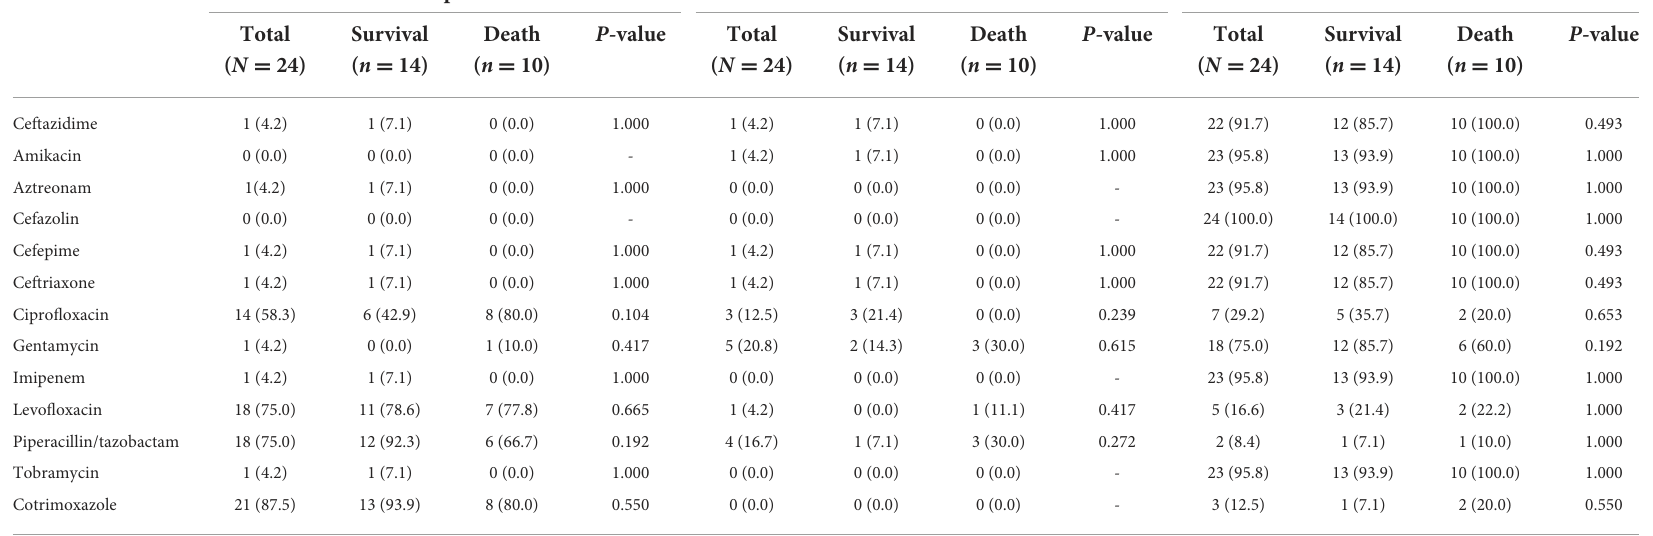
TABLE 4 The original “TABLE 4 In vitro of drug susceptibility results of patients infected with E. meningoseptica ( N = 24).”